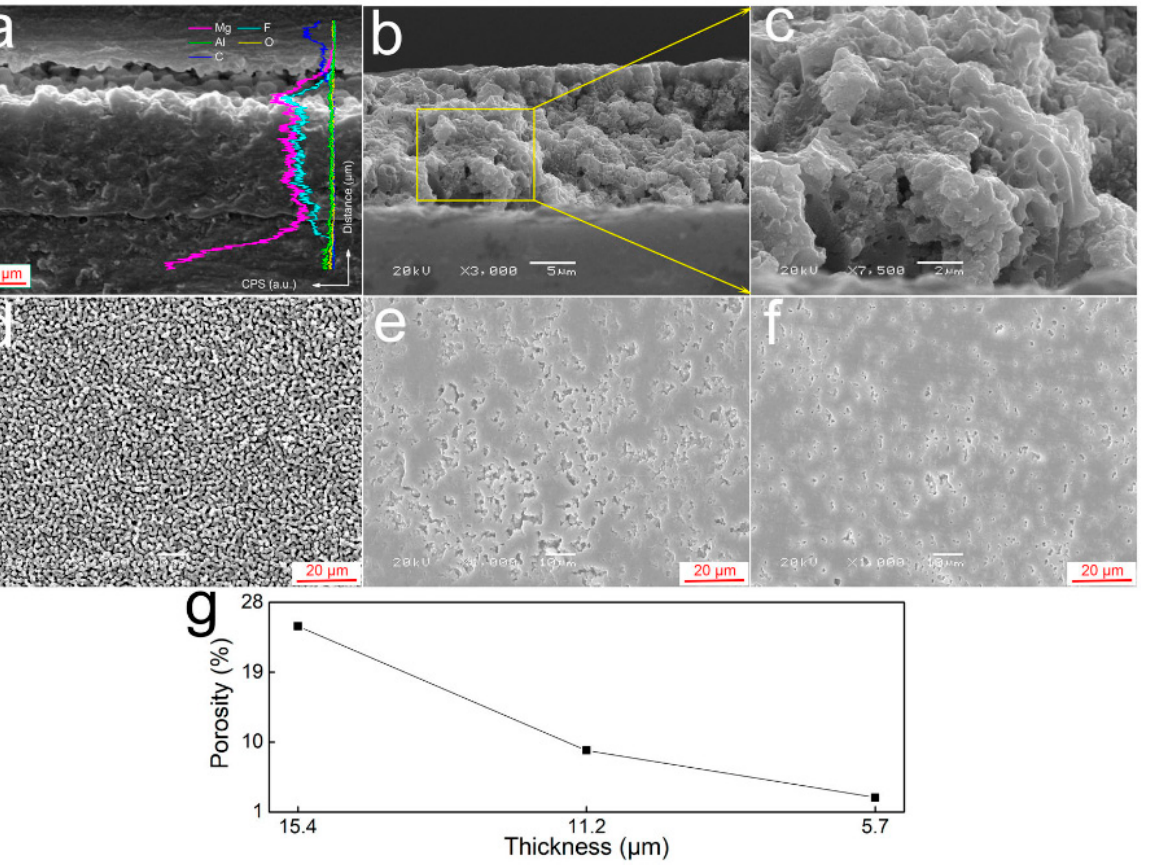
Figure 17. Cross-sectional secondary ( a – c ) and planar view ( d – f ). Electron micrographs of PEO coating on AZ31B alloy formed in ethylene glycol and NH 4 F electrolyte: ( a ) polished morphology and EDS line-scanning, ( b ) fractured morphology, ( c ) enlarged view of ( b ); morphology of as-coated surface ( d ), the coating polished to 11.2 µm ( e ) and 5.7 µm ( f ); ( g ) porosity statistics [262]. Reprinted from [262] with permission from Taylor & Francis.